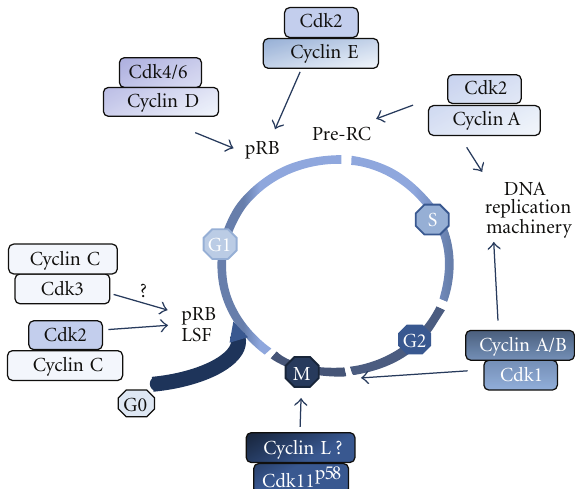
Figure 6: Sequential activation of Cdk/cyclin complexes through- out the cell